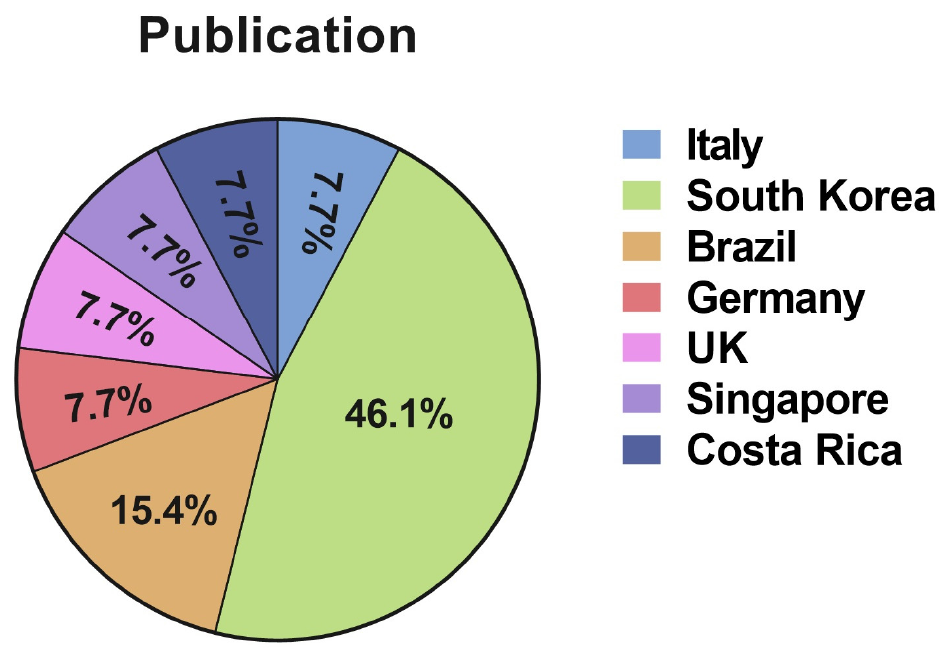
Figure 3. Country distribution of selected Motiva studies.